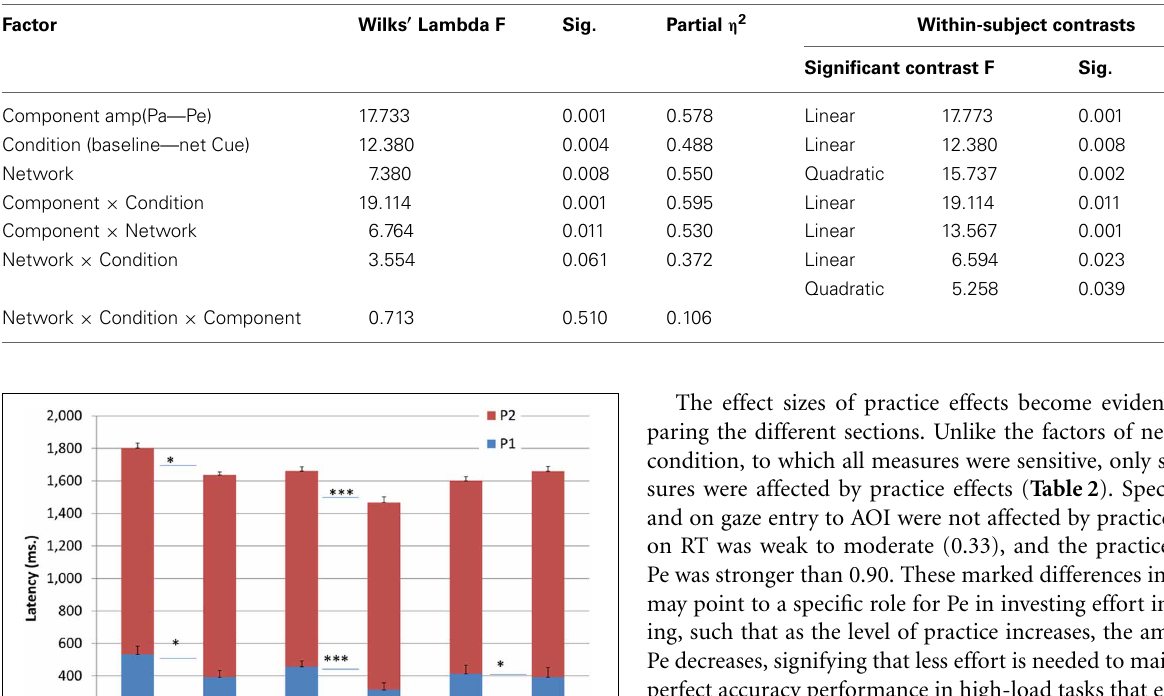
Table 1 | Repeated measures analysis of PD components: Pa and Pe as a function of attention network and conditions.